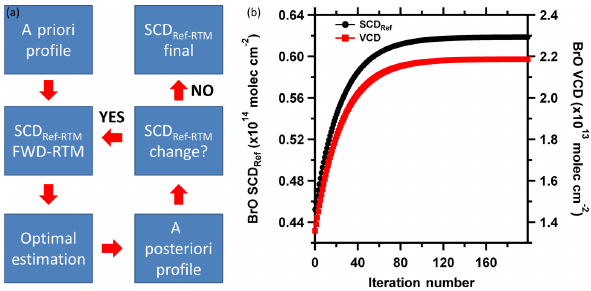
Figure 3. Conceptual sketch of the SCD Ref retrieval (a) and result- ing SCD Ref values (black trace, b ). The sensitivity of the a posteri- ori BrO VCD (red trace) to SCD Ref is also shown (b) .